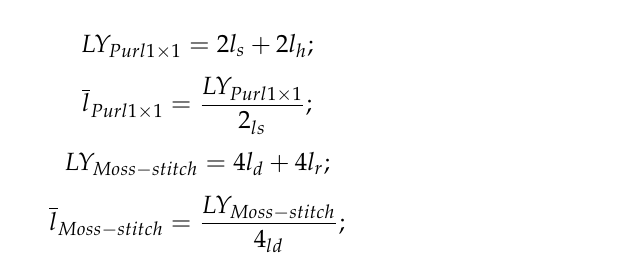
Table 4. Theoretically calculated yarn length in the pattern repeat, average loop length and relative error between the theoretically calculated and experimentally measured values. Relative Error Average Loop Yarn Length in the between Theoretical Length in the Pattern Pattern Pattern Repeat LY , and ¯ mm l , mm Repeat